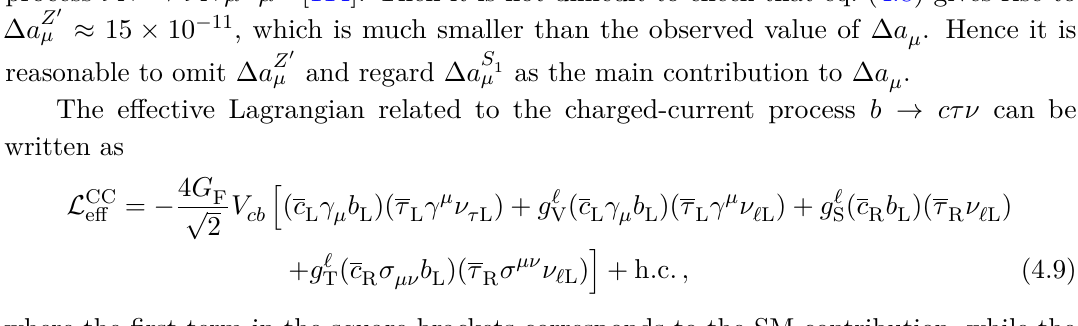
to the b → cτν . 1 . Hence it is µ . µ